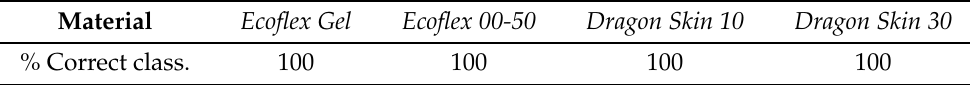
Table 5. Percentage of correct classifications when considering ˆ k l and ˆ k nl for the SBC. Material Ecoflex Gel Ecoflex 00-50 Dragon Skin 10 Dragon Skin 30 % Correct class. 100 100 100